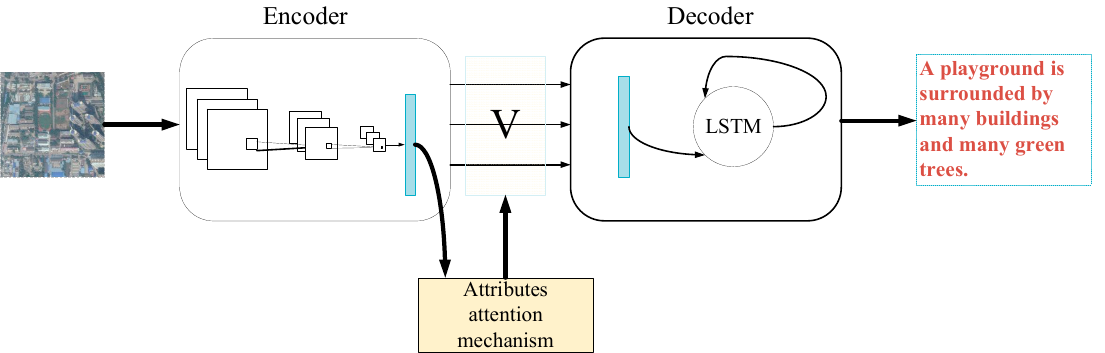
Figure 1. The framework of the proposed model.